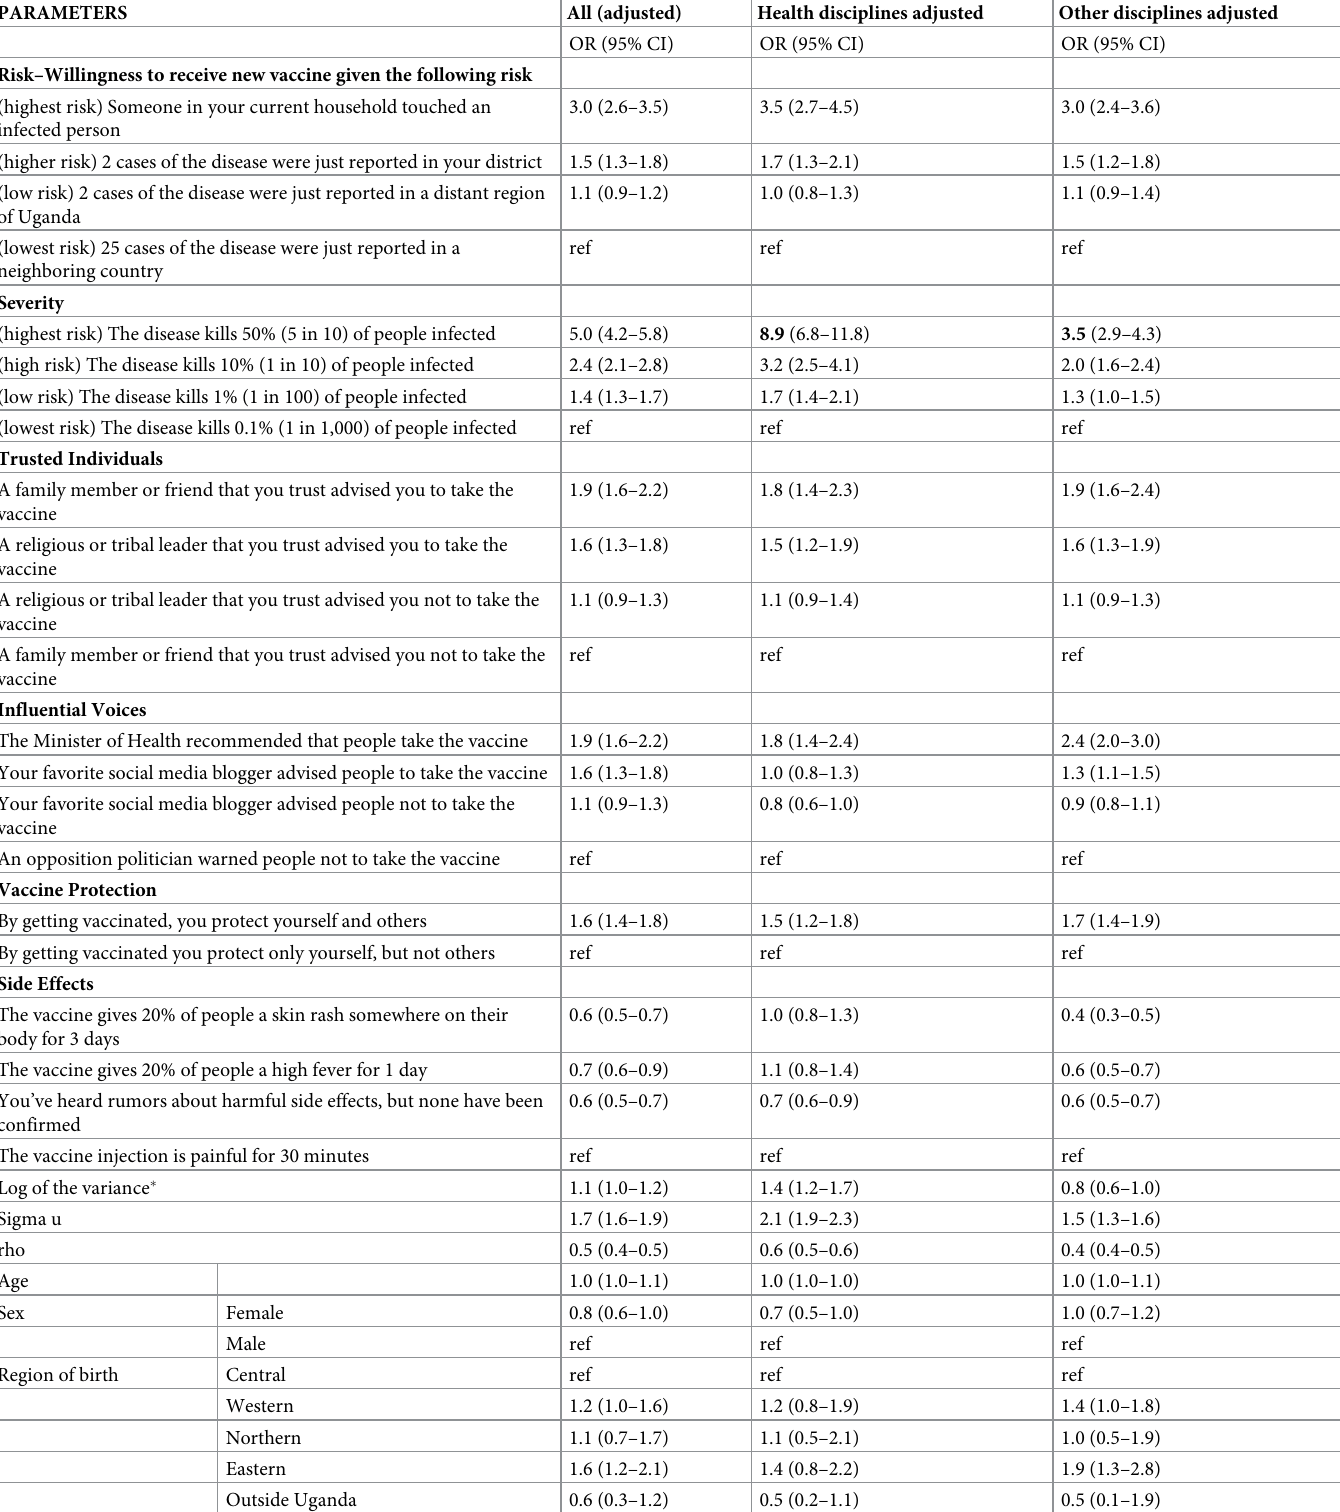
Table 4. Estimating the odds ratio (OR) of attribute-specific parameters associated with willingness to receive a new vaccine t .